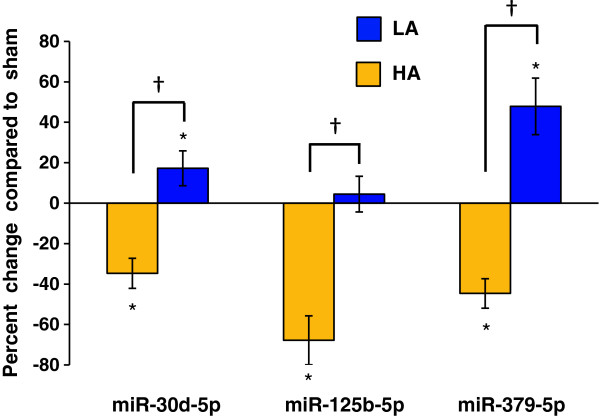
Differential regulation of miRs 125b-5p, 30d-5p and 379-5p was confirmed using qRT-PCR. Columns represent up- and down-regulation of miRNA expression in SNL operated HA and LA rats as a percent of sham control values. * p ≤ 0.05 vs. sham; † p ≤ 0.05 comparing regulation in HA vs. LA (diff-reg), one-way ANOVA followed by Turkey post-hoc test.